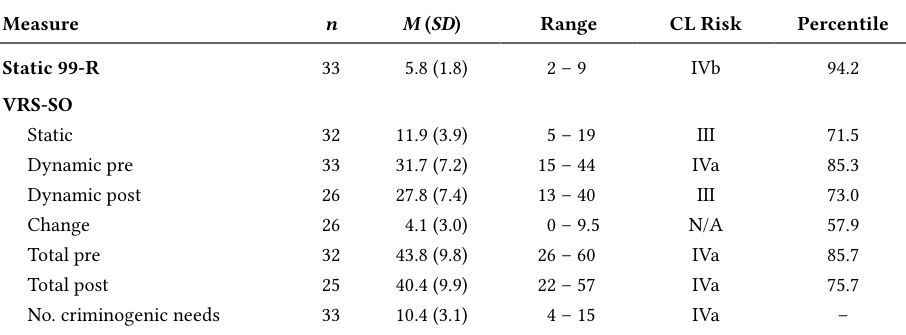
VRS-SO and Static-99R Risk-Need Profile for Canadian Dangerous Offender Sample Measure n M ( SD )